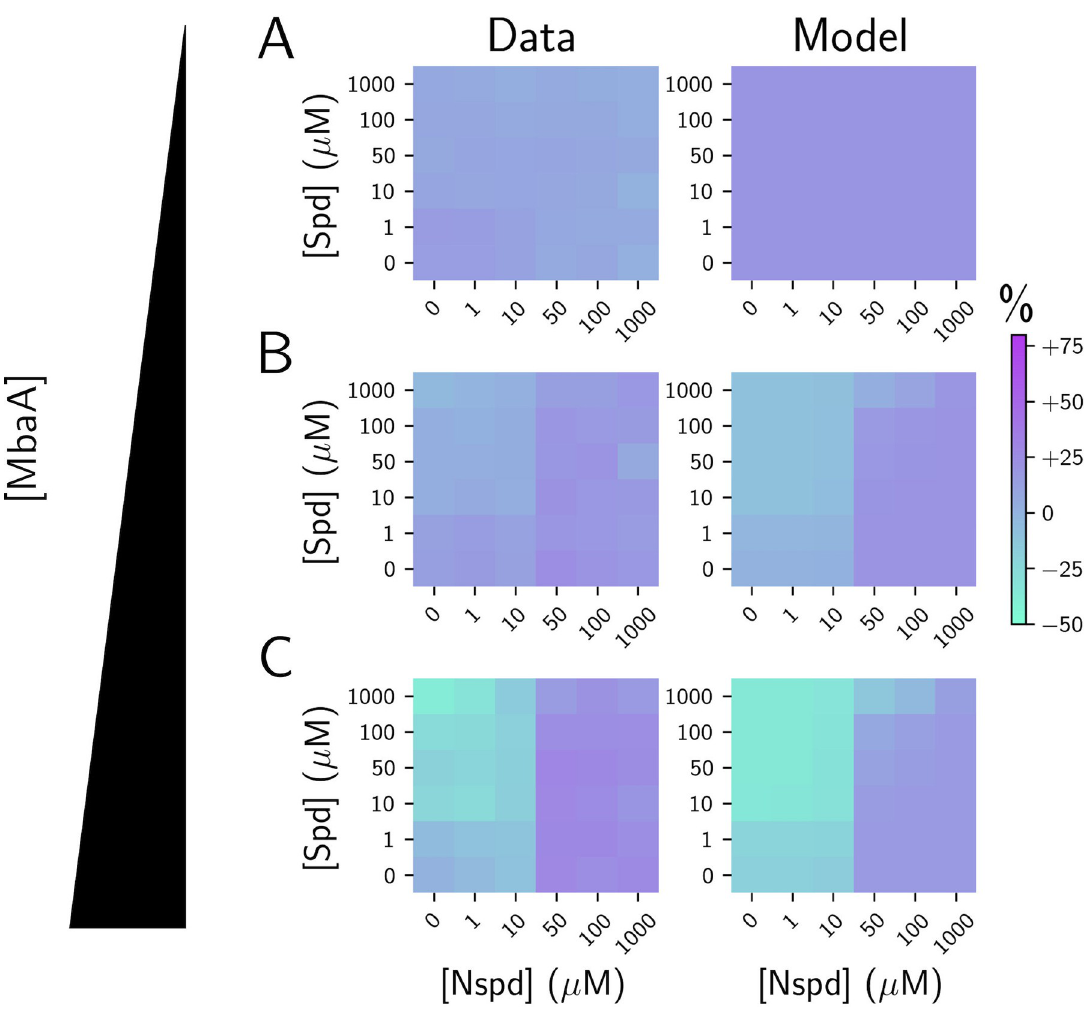
Fig 2. The fitted mathematical model of NspS-MbaA input–output dynamics accurately predicts the outcomes of perturbations to MbaA protein levels. (A) Left panel: experimentally obtained results for c-di-GMP reporter output in Δ mbaA V . cholerae carrying Pbad - mbaA for the indicated polyamine concentrations at 0% arabinose, shown as a heatmap. Throughout the manuscript, data in c-di- GMP output heatmaps are displayed as percent differences compared to the untreated wild-type strain, with teal representing low and purple representing high c-di-GMP reporter output, respectively. Right panel: modeled c-di-GMP reporter output for Δ mbaA V . cholerae based on a global fit to the experimental data for the wild-type, Δ nspS , Δ mbaA , and Δ potD1 strains. (B) Left panel: as in A, left panel, but with supplementation of 0.05% arabinose. Right panel: modeled c-di-GMP reporter output for V . cholerae with approximately 2.5-fold lower MbaA levels than in wild-type V . cholerae . (C) Left panel: as in A, left panel, but with supplementation of 0.2% arabinose. Right panel: as in A, right panel, but for approximately 1.5-fold higher MbaA concentration than in wild-type V . cholerae . N = 3 biological replicates. Numerical values for plots are available in S1 Data. c-di-GMP, cyclic diguanylate; Nspd, norspermidine; Spd, spermidine.